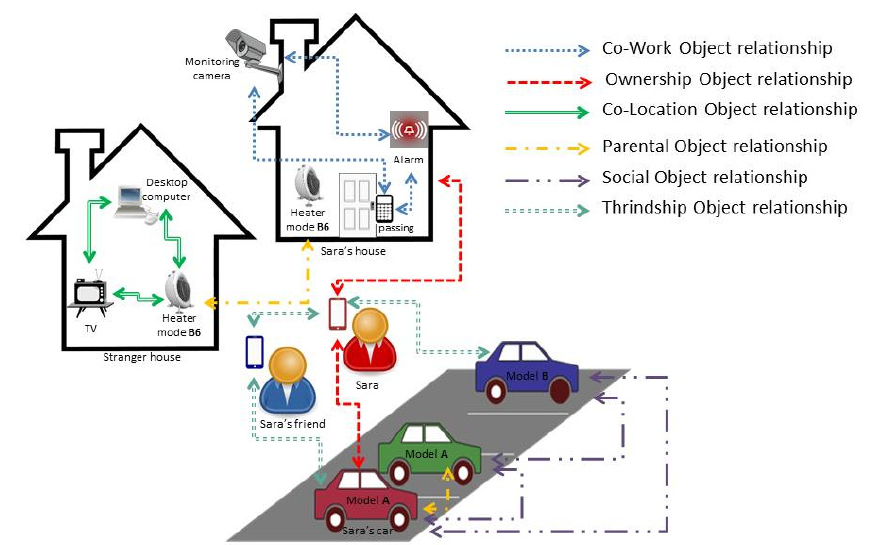
Figure 1. SIoT objects relationships comparison.